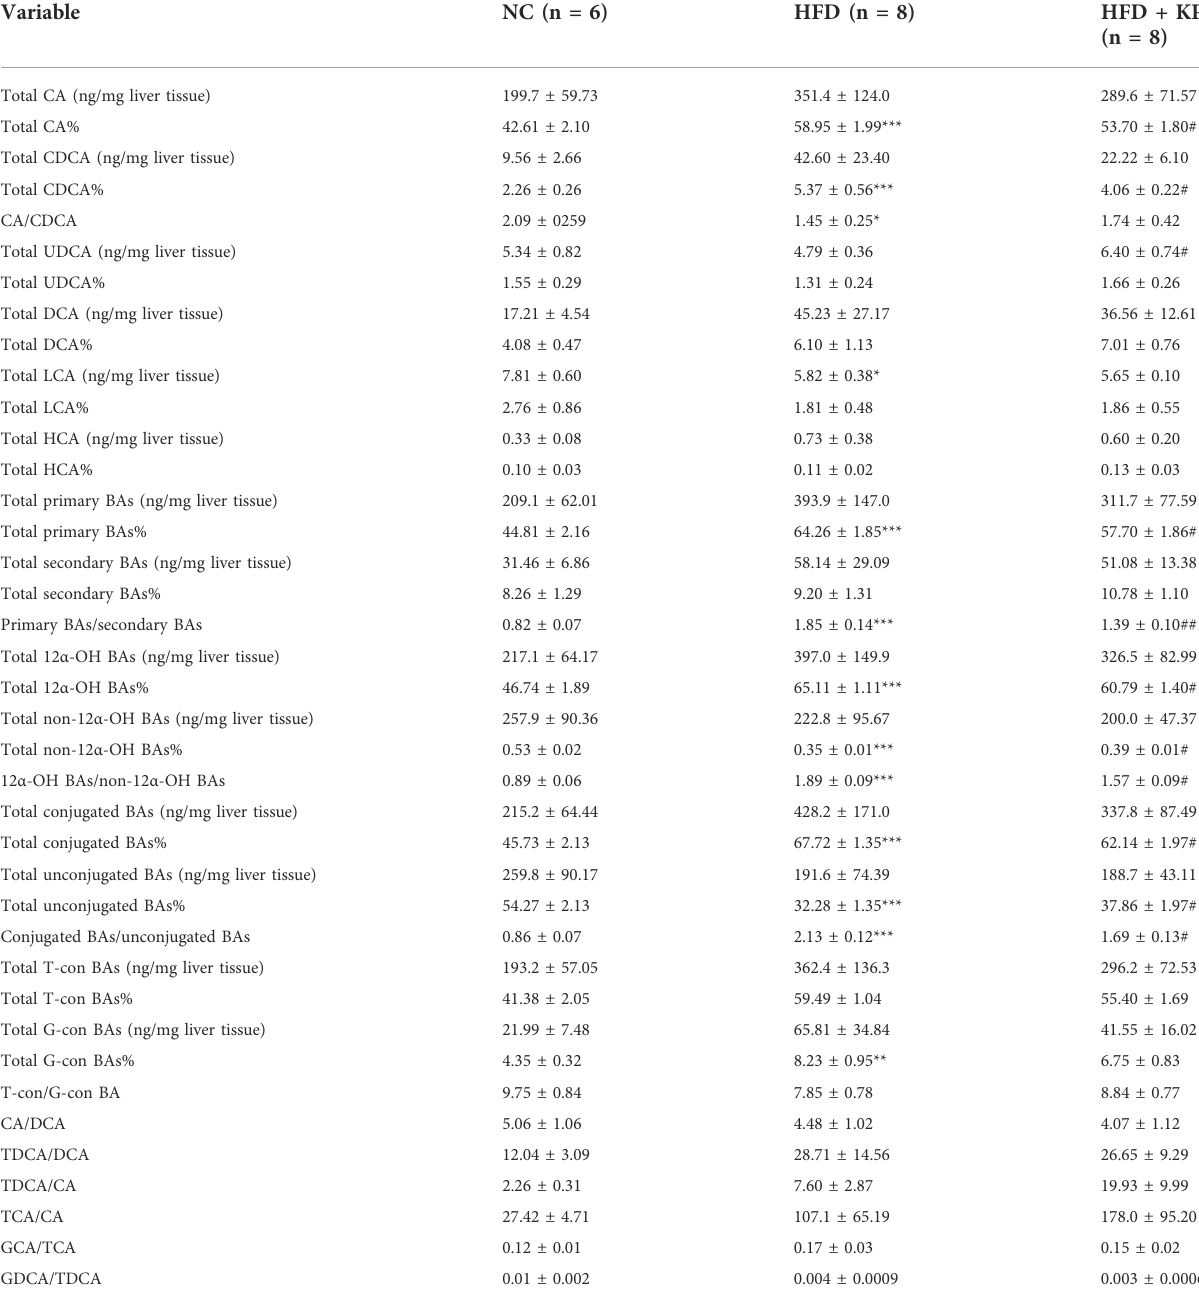
TABLE 4 Liver BA ratios and percentage altered signi fi cantly among three